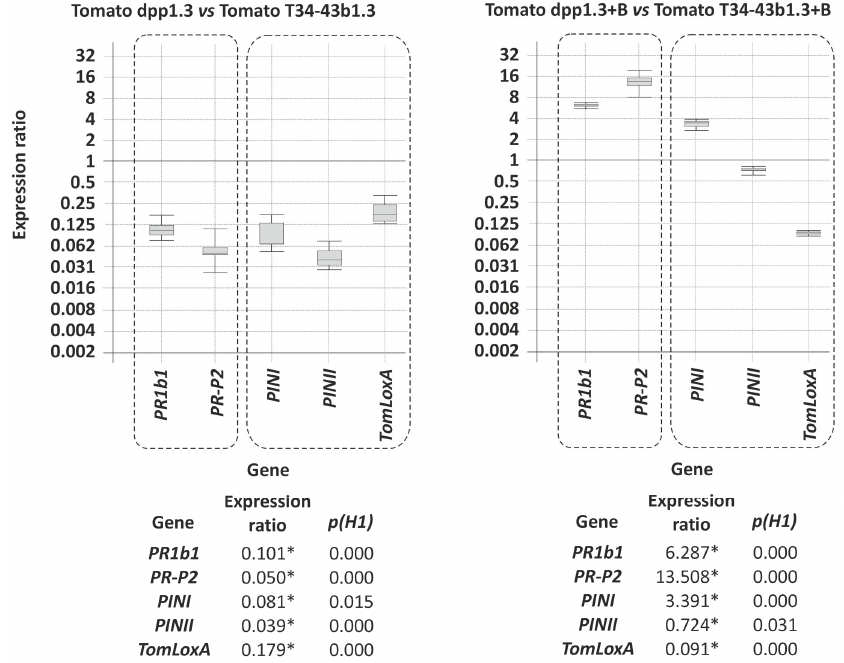
Figure 8. qPCR analysis of expression of five tomato defense-related genes. The relative expression of these genes has been analyzed in leaves grown from tomato seeds coated with T34 ‐ dpp1.3 versus leaves from seeds inoculated with T34 ‐ 43b1.3, in both cases without Botrytis cinerea B05.10 infection ( left panel ), or leaves from the same plants after infection with B. cinerea ( right panel ). Tomato ‐ actin gene has been used as a housekeeping ‐ reference gene in this study. In the graphic representa ‐ tion, those statistically significant differential expression data ( p < 0.05) are squared with dashed lines and numeric values were labeled with an asterisk (*) at the bottom of each graphic.. 3.9. Effect of dpp1 Overexpression on the Trichoderma Antifungal Activity 3.9.1. Antifungal Activity against B. cinerea B05.10 on Tomato Leaves This analysis was performed using 96 h grown PDB culture broths from T34 ‐ 43b1.3, T34 ‐ dpp1.2, and T34 ‐ dpp1.3. Two 15 l aliquots of a B. cinerea spore suspension, 5 × 10 5 spores/mL, were deposited onto tomato leaves, each aliquot at a different position in the leaf. Once the aliquots had dried, a 15 μ L aliquot of a culture broth from one T. harzianum strain was deposited on each dried spot of B. cinerea spores. Leaves were then incubated on a humid atmosphere for 72 h, after which the size of any resulting lesions was meas ‐ ured. No significant differences were observed in the sizes of lesions resulting from the treatment of broth of the wild ‐ type strain and the two dpp1 overexpressing transformants (Figure S7). Thus, the overexpression of dpp1 did not have a significant effect on the anti ‐ fungal activity of T. harzianum against the pathogen B. cinerea . 3.9.2. Antifungal Assays on Membranes against R. solani Metabolites secreted by the three Trichoderma strains assayed in this study, T34 ‐ 43b1.3, T34 ‐ dpp1.2, and T34 ‐ dpp1.3, did not have any significant inhibitory effect on R. solani growth (Figure S8). Thus, similar to the results with B. cinerea shown above, the overexpression of dpp1 did not affect the antifungal activity of T. harzianum against the pathogen R. solani .